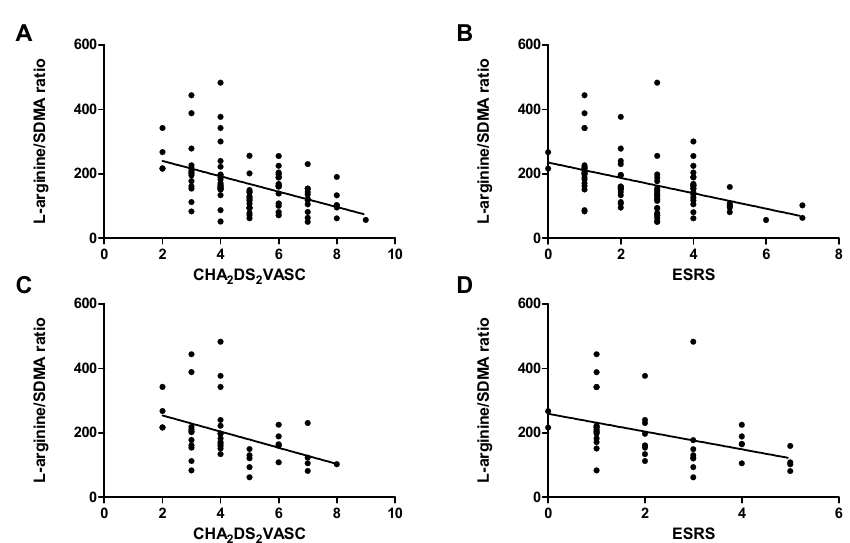
Figure 4. Correlation of L-arginine/SDMA ratio with CHA 2 DS 2 VASC ( A ) and ESRS ( B ) in the whole sample and within the ESUS collective ( C , D ). A: Spearman’s r: − 0.50, p < 0.001; B: Spearman’s r: − 0.46, p < 0.001; C: Spearman’s r: − 0.47, p = 0.002; D: Spearman’s r: − 0.53, p < 0.001.